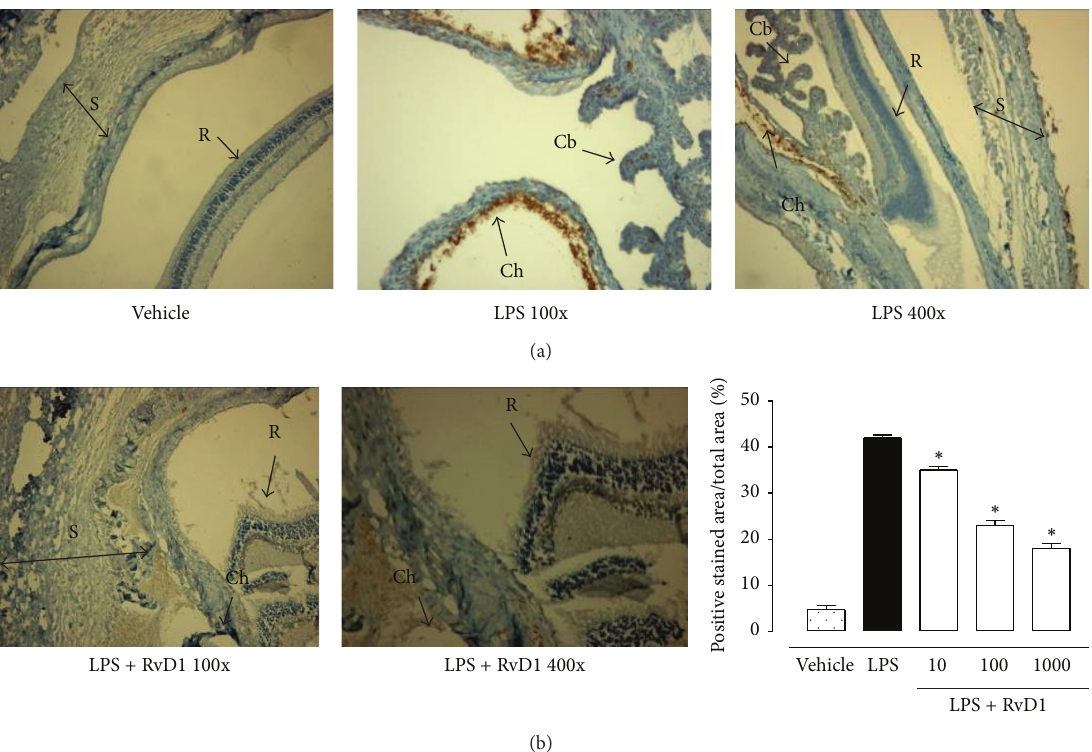
Figure 2: Intravitreal Resolvin D1 (RvD1) reduces CD4 + immunostaining. (a) Representative immunohistochemistry of ocular tissues showing that treatment with RvD1 decreases immunostaining for CD4 + T cells, already significant at the lowest dose (10ng/kg, 1h post- LPS treatment) with respect to the LPS treated rats. (b) Graph showing the percentage of the total positive stained area for CD4 + per total areaanalyzedat400xmagnification.Valuesaremean ± SEMof 𝑛 = 6 observationforeachgroup. ∗ 𝑃 < 0.05 and ∗∗ 𝑃 < 0.01 versusLPS-treated group. R = retina; S = sclera; Ch = Choroid; Cb = ciliary